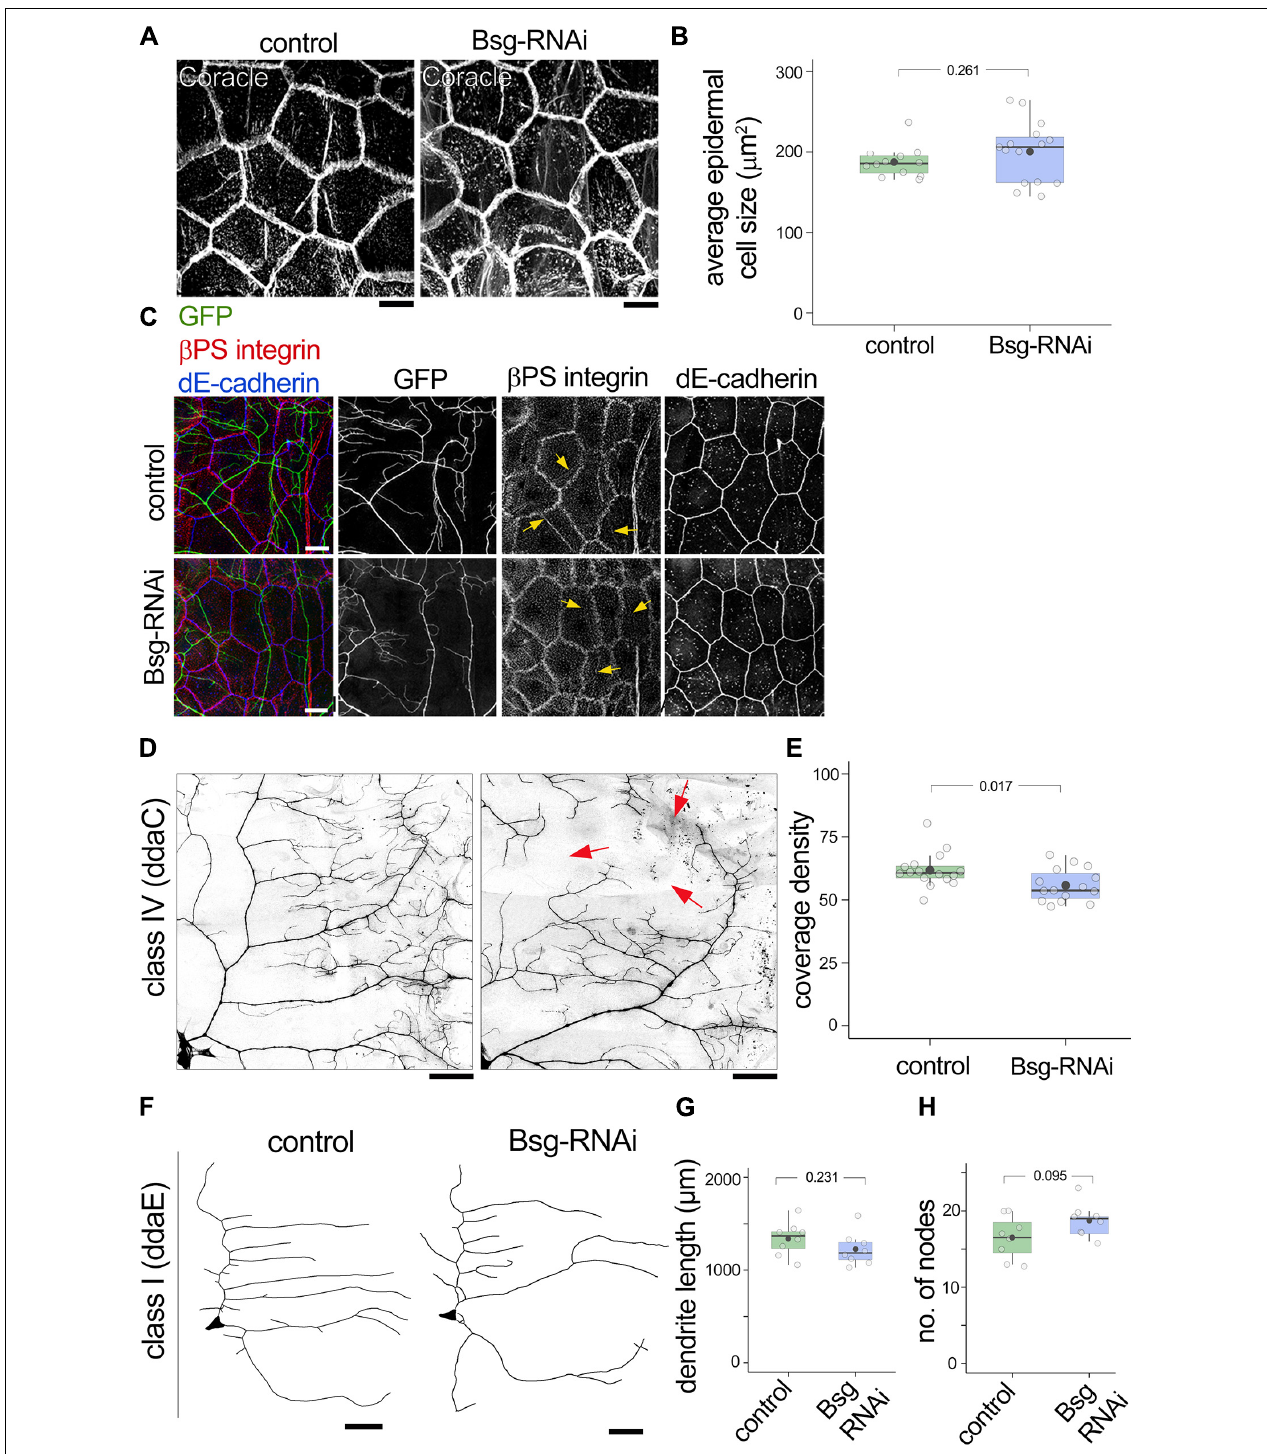
FIGURE 7 | Basigin is required cell-non autonomously in substrate epidermal cells for class IV dendrite morphogenesis. (A) Basigin was knocked down in the epidermis by driving UAS-bsg-RNAi using the 871-Gal4 driver. Gross morphology of epidermal cells and expression of the septate junction resident protein Coracle remained unaltered (A,B) . Epidermal localization of β PS integrin and dE-cadherin (C) were indistinguishable in control and Bsg-RNAi animals. Notably, epidermal β PS integrin localization along dendrites (yellow arrows in C ) persisted. GFP signal in (C) is from the ppk-CD4tdGFP transgene. (D,E) Knocking down Basigin in the epidermis caused aberrant dendrite morphogenesis in class IV da sensory neurons. Red arrows in (D) mark areas with large gaps in dendritic field. Class I neurons (F) did not exhibit significant change in total dendrite length (G) or number of nodes (H) . Scale bar, 25 µ m. p values are indicated for Welch’s t -test.